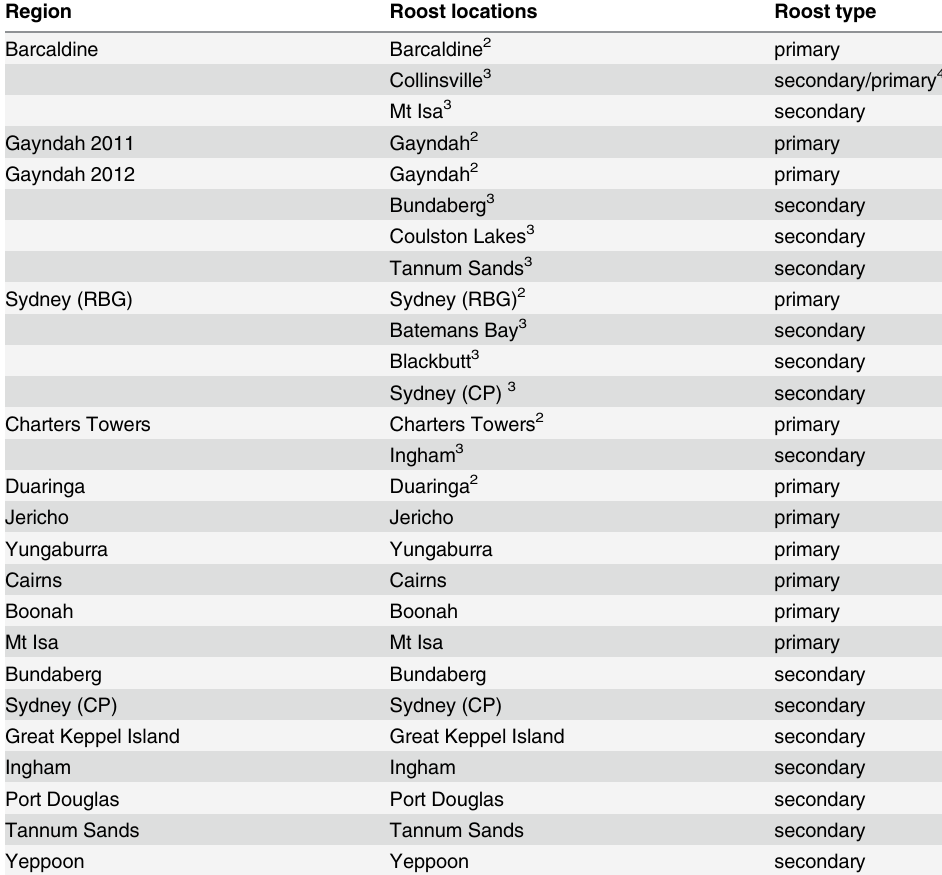
Table 1. Relationship between 21 roosts and 18 regions 1 monitored in the eastern Australian states of Queensland and New South Wales between September 2011 and November 2012.